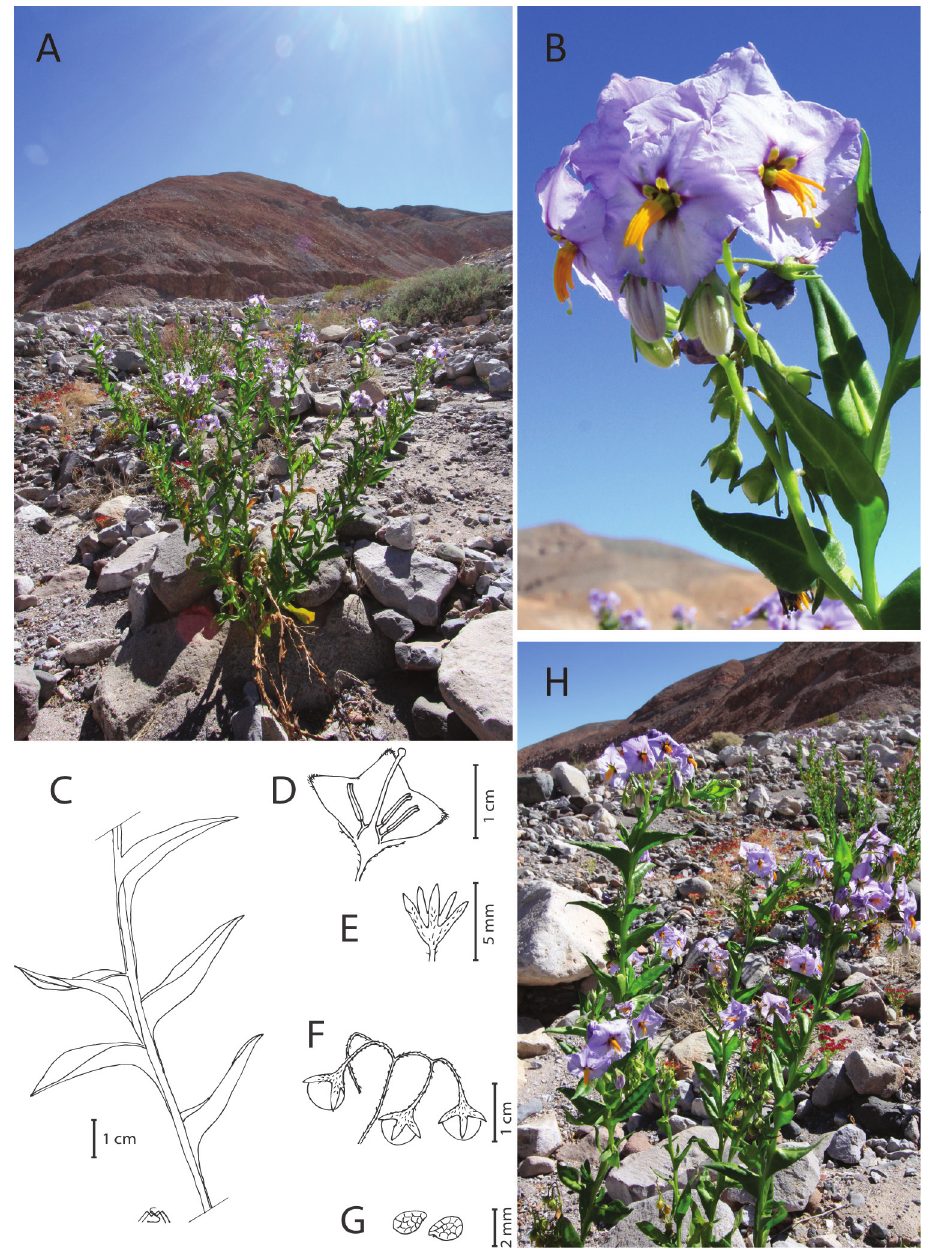
Figure 2. Solanum polyphyllum at an alluvial cone at the Tarapacá precordillera A habitat B flower de- tails C leaves D flower E calyx F fruits G seeds H habit. Photos by A. Moreira-Muñoz, drawings by M.